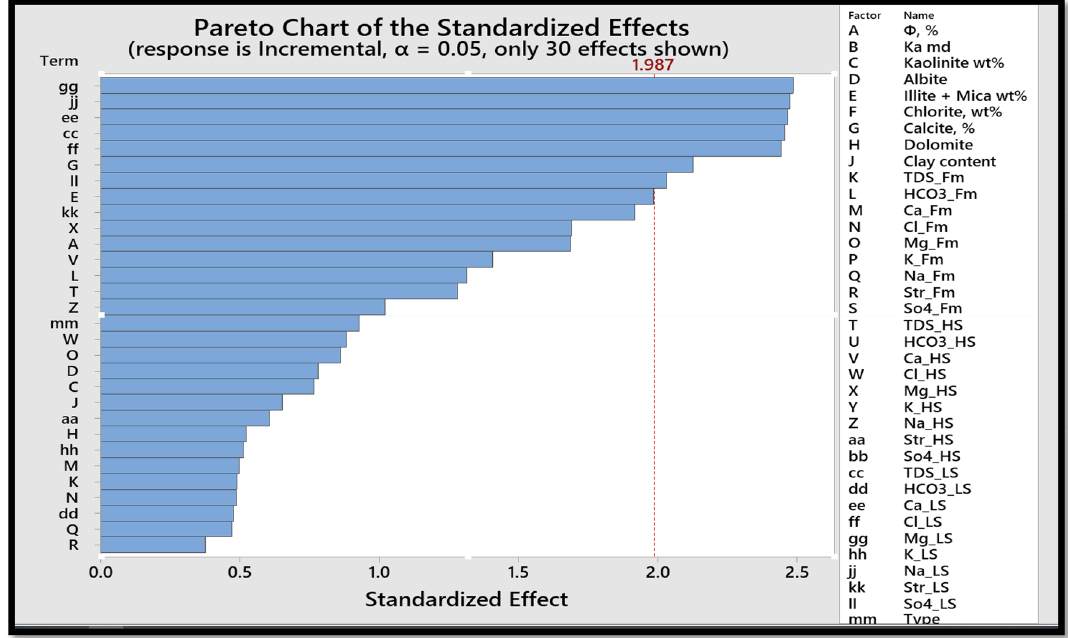
Fig. 7 Pareto chart using the complete dataset of the secondary and tertiary